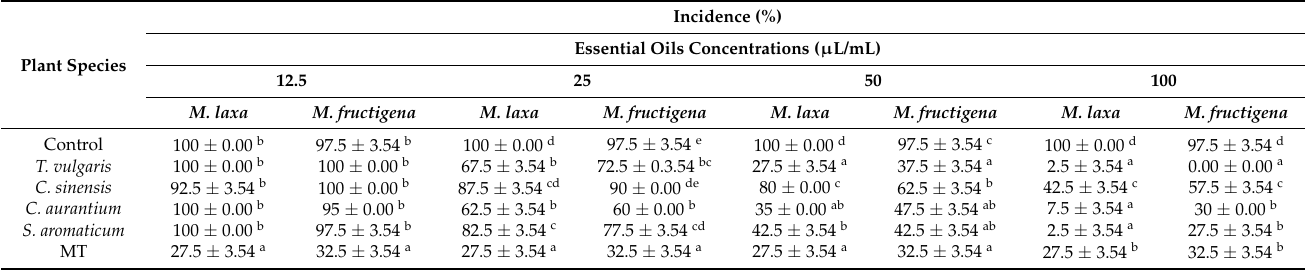
Table 5. Effect of essential oil concentrations on brown rot incidence caused by Monilinia laxa and Monilinia fructigena in apple fruit incubated at 4 ◦ C for 20